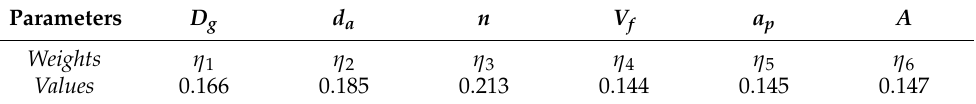
Table 4. Strength of influence of process parameters.